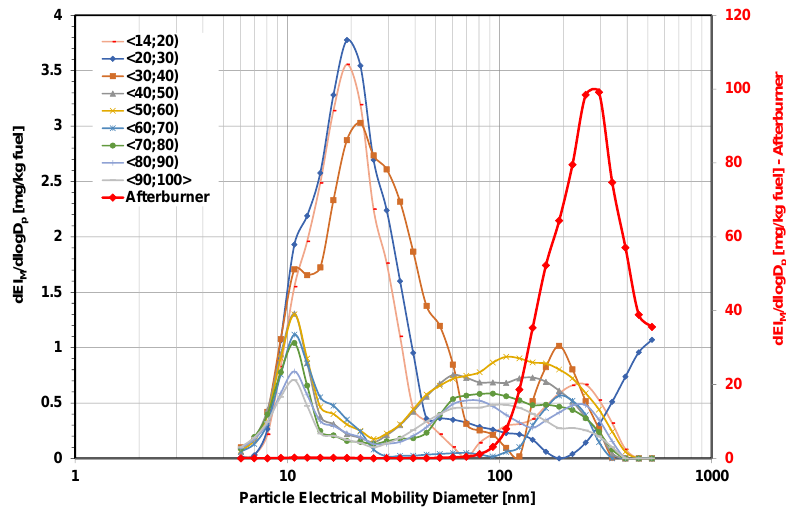
Figure 5. Differential Particle Mass Emission Index (EI M ) PSD for the entire range of engine operation and the afterburner.